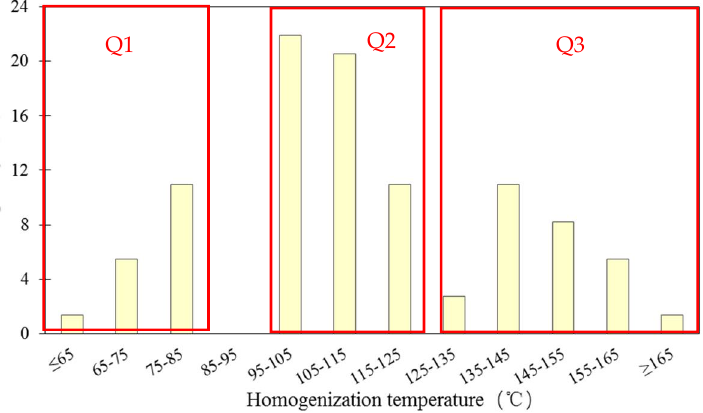
Figure 5. Histograms of the homogenization temperature (Th) in the different phases of the quartz cements in the Xu2 sandstones.